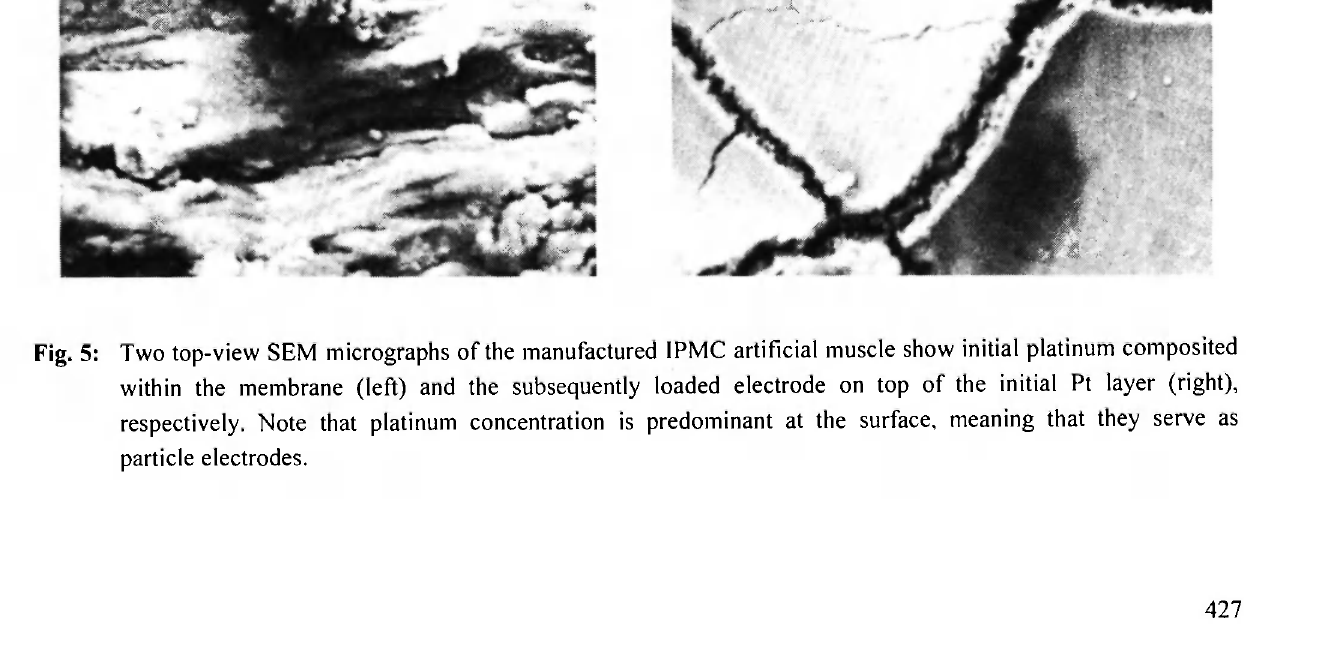
Fig. 4: A high resolution TEM micrograph shows a cross-section of the typical I PMC